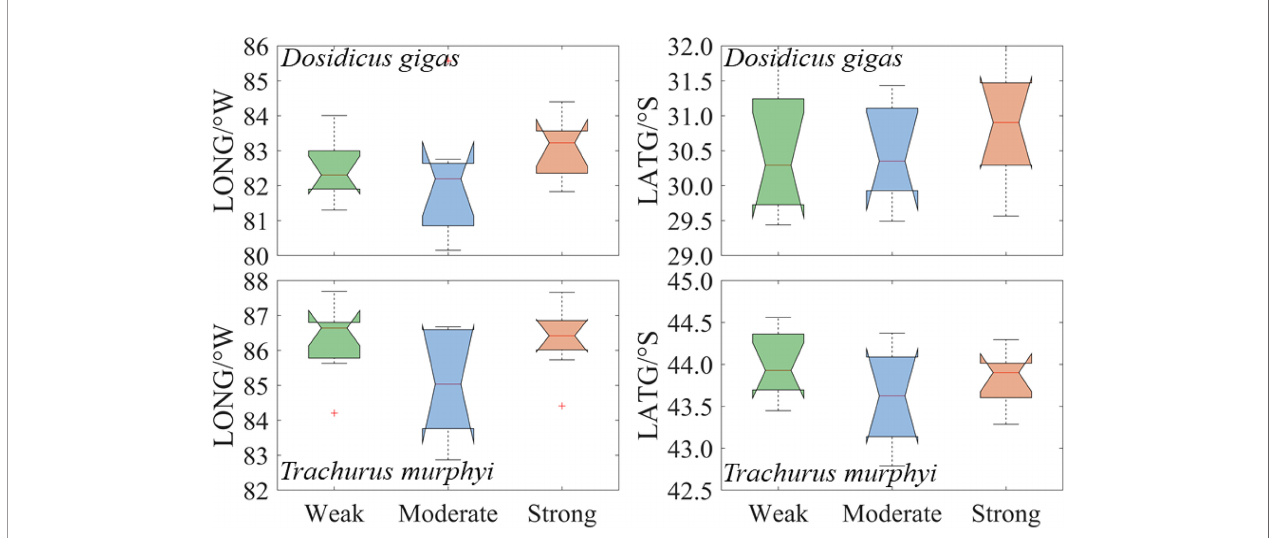
FIGURE 7 | Changes in the longitudinal and latitudinal gravity center of the suitable habitat of Dosidicus gigas and Trachurus murphyi under El Niño events with different intensities. (The nodes of the boxplot from top to bottom are the upper edge, upper quartile, median, lower quartile, and lower